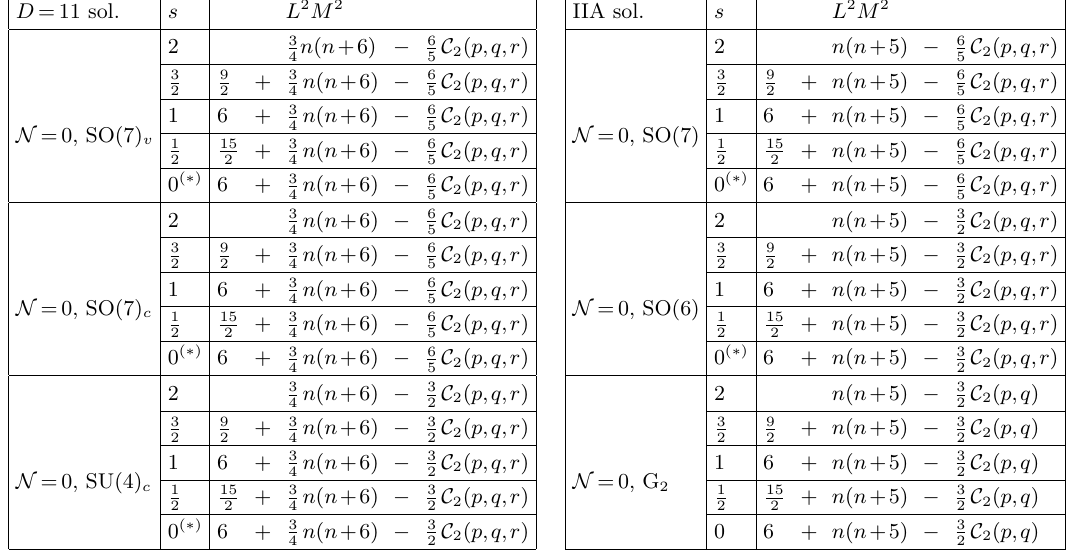
Table 17 . The complete KK spectra for the analytic non-supersymmetric AdS 4 solutions of D = 11 supergravity (left) and massive type IIA supergravity (right) that respectively uplift from critical points of D = 4 N = 8 SO(8) and ISO(7) supergravities, with residual symmetry groups larger than SU(3). For each KK field of spin s , its squared mass M 2 L 2 is given at all KK level n . The spectra also depend on the quadratic Casimir operators C 2 specified in the text. The scalar spectra marked with ( ∗ ) are